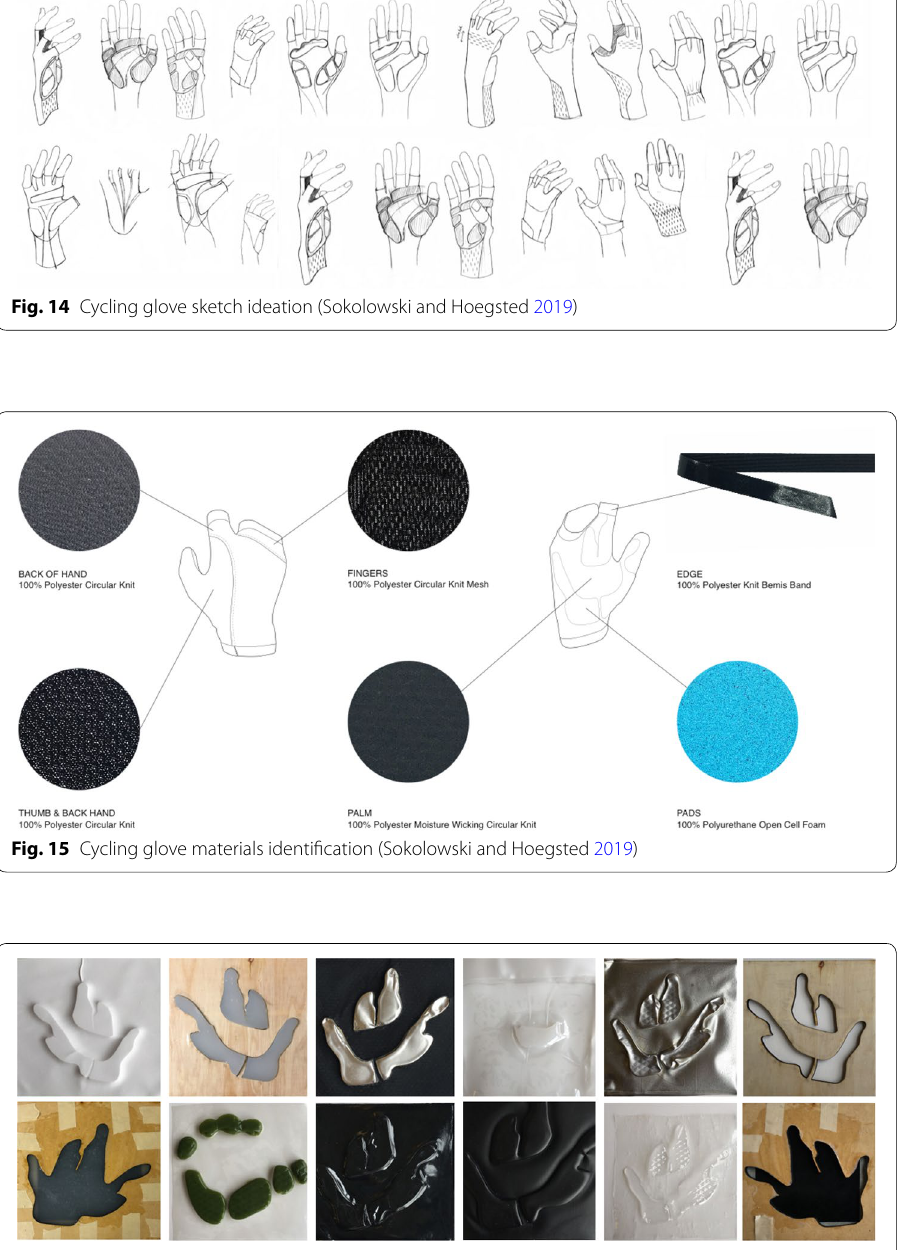
Fig. 16 Cycling glove palm cushioning prototypes (Sokolowski and Hoegsted